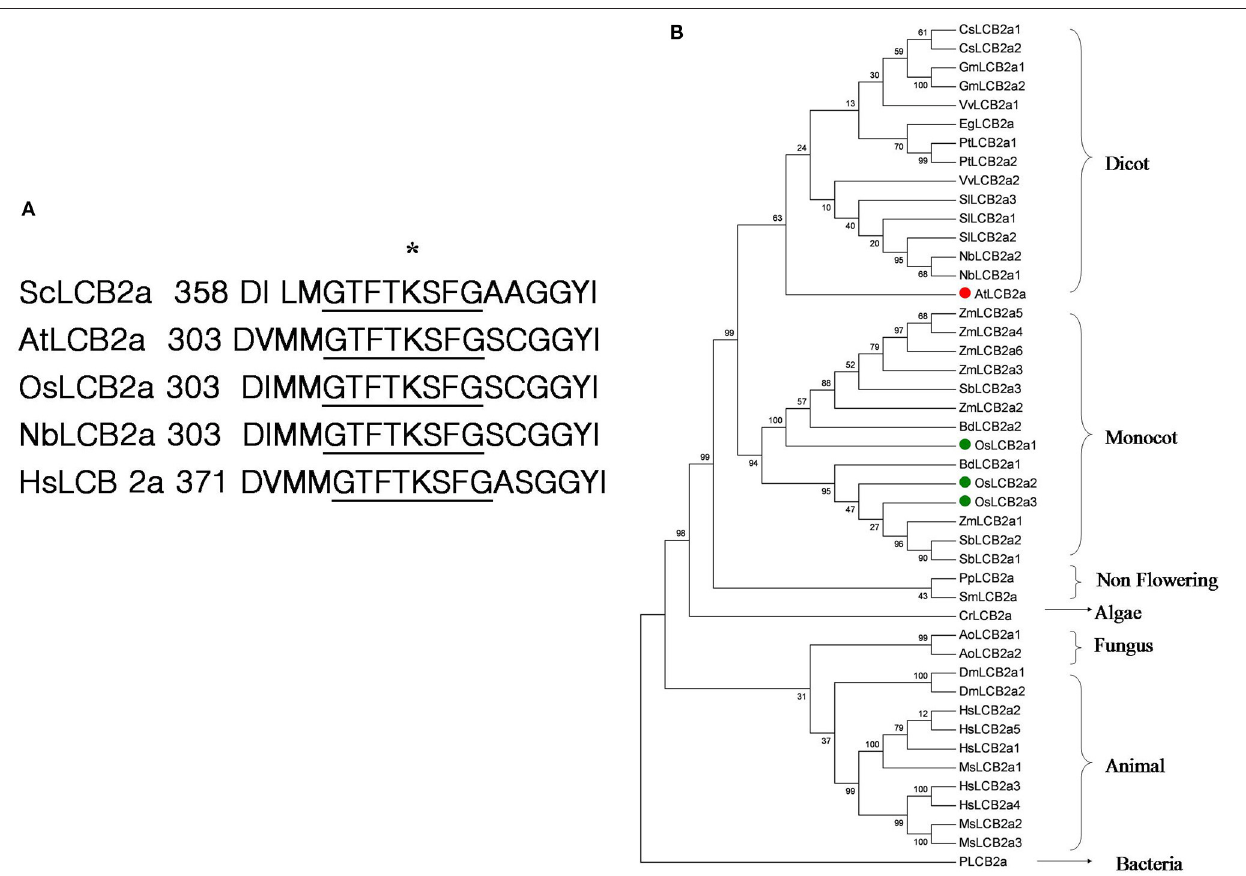
FIGURE 1 | (A) Comparison of the pyridoxal 5 ′ -phosphate (PLP)-binding motif of LCB2a. Species are indicated as follows: Nb, Nicotiana benthamiana ; At, Arabidopsis thaliana ; Os, Oryza sativa ; Hs, Homo sapiens ; Sc, Saccharomyces cerevisiae . An asterisk marks the PLP-binding lysine residue. (B) Phylogenetic tree of LCB2a homolog in different